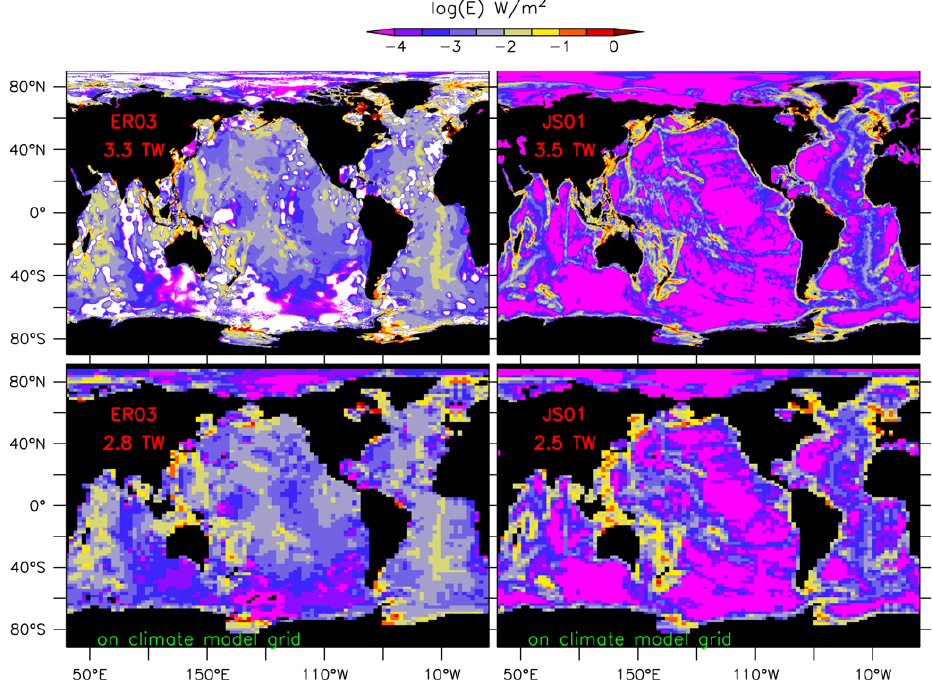
Fig. 1. Logarithm of total energy flux out of the barotropic tide E (Wm − 2 ) estimated from satellite altimetry (ER03, left) and a tide model (JS01, right). Top: data on high resolution grid. Bottom: data averaged on climate model grid. Negative values for ER03 are shown in white and have been set to zero on the climate model